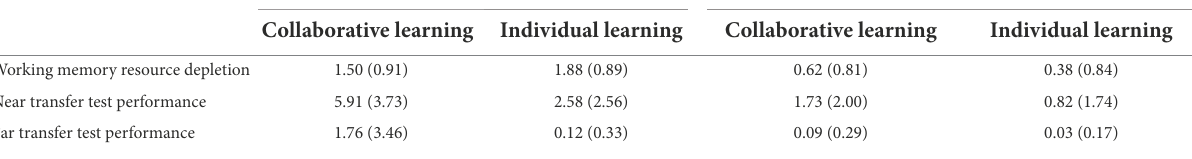
TABLE 1 Results (means and standard deviations) for the dependent variables of Experiment